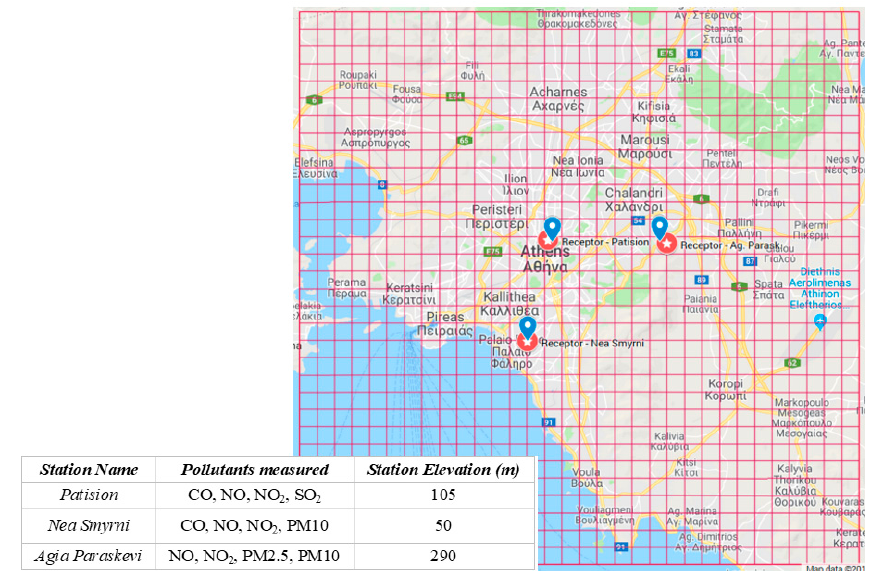
Figure 4. Monitoring station details, where measurements and simulations are compared for model validation (figure modified from Google Maps).